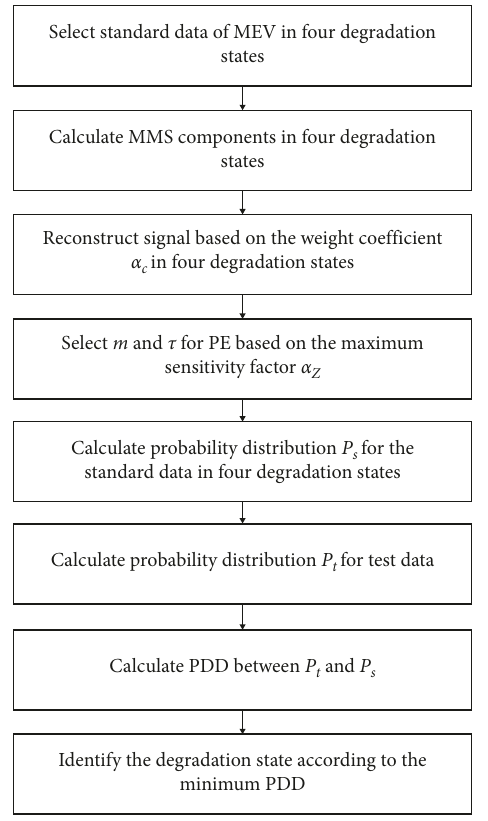
Figure 1: The flowchart of degradation state